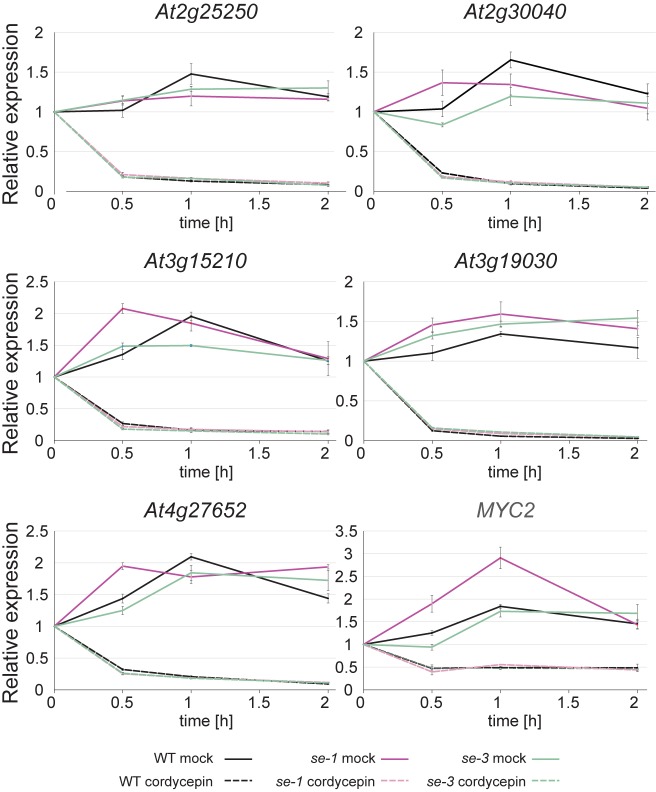
The stability of RNAs produced by SE target genes is not affected SE.Analysis of RNA stability in WT, se-1 and se-3 mutants. Plants grown in liquid culture were treated with 200 µg/ml cordycepin for 0.5 hr, 1 hr and 2 hr to block transcription. Mock treatment served as a control. Quantification of indicated RNA transcript level was performed by qPCR. Error bars denote the standard error of 3 biological replicates.